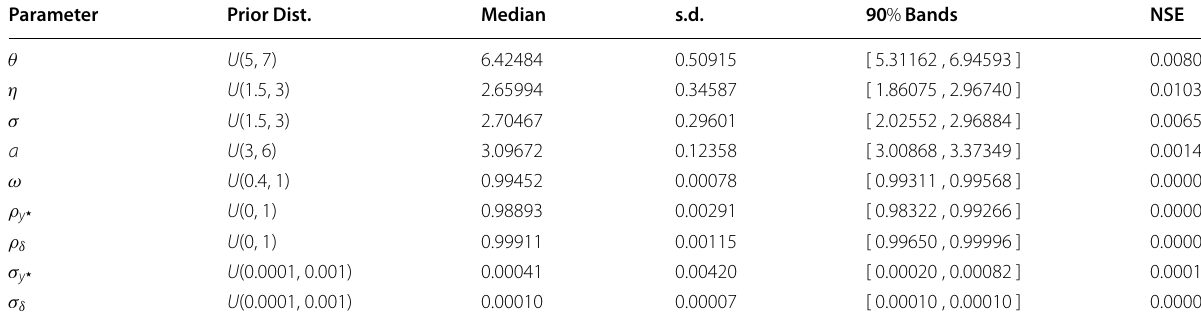
Table 2 Posterior Distributions of Structural